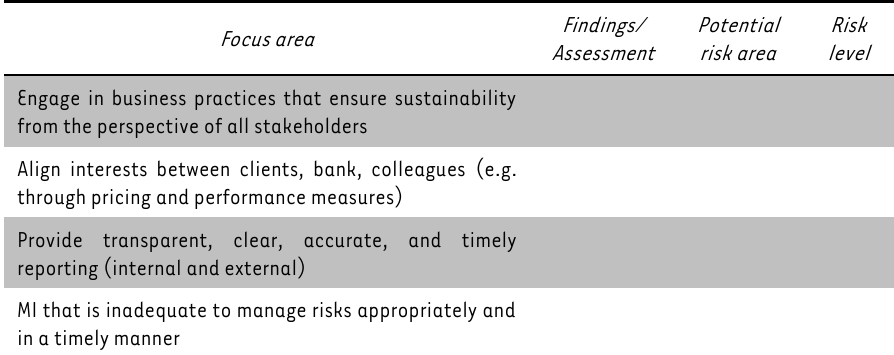
TABLE 4: Template of ‘how’ assessment of reputational risk